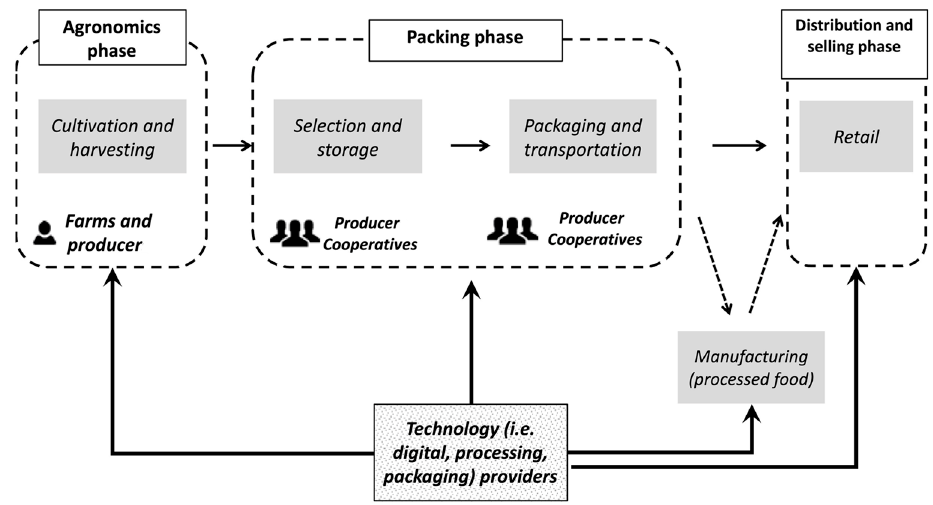
Figure 1. Food supply chain (Reproduced with permission from Ciccullo et al. (2021) [5].